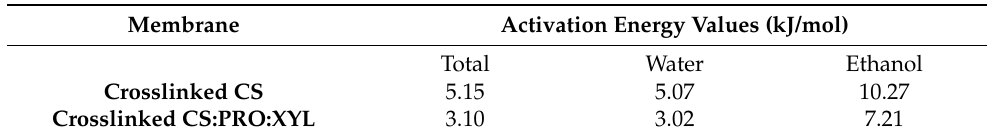
Table 1. Apparent activation energy values for total permeate, water and ethanol fluxes of the prepared